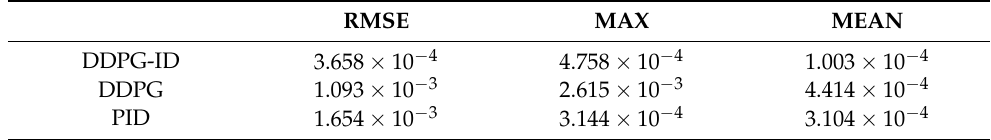
Table 6. Tracking errors comparison of different controllers in the waved